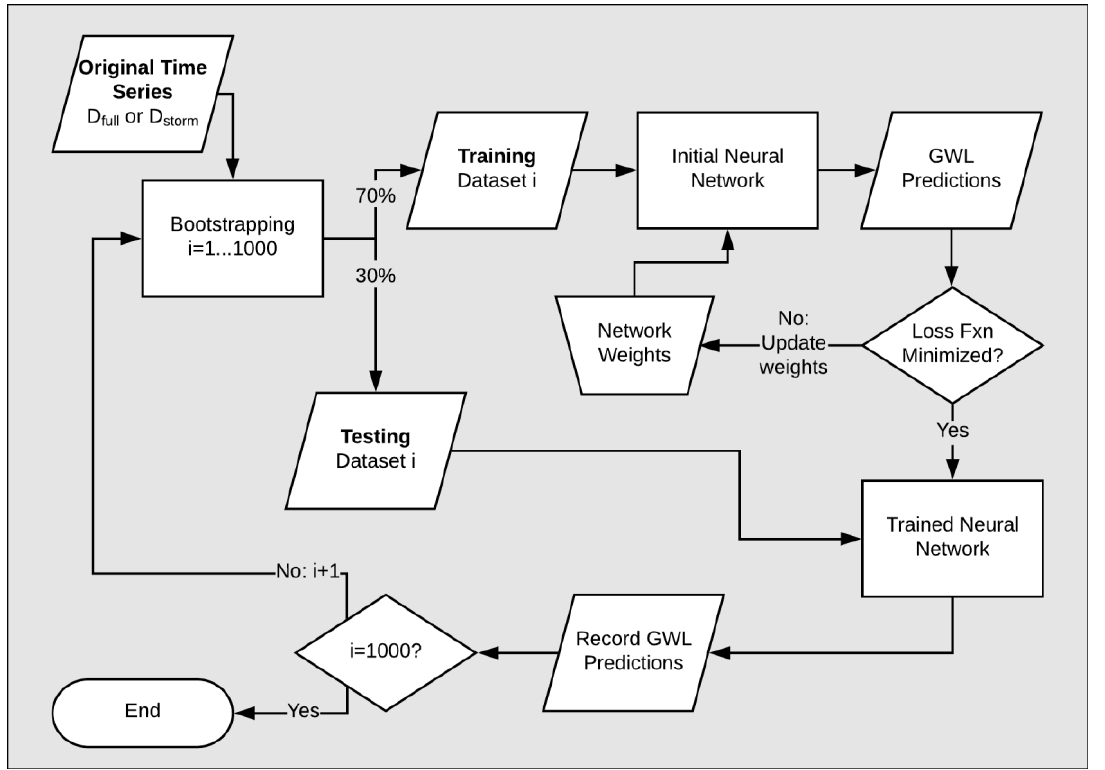
Figure 5. Model training and evaluation with bootstrapped datasets.